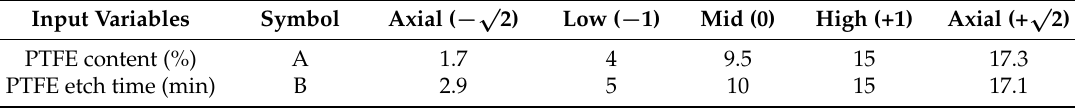
Table 1. List of input variables with their corresponding levels and